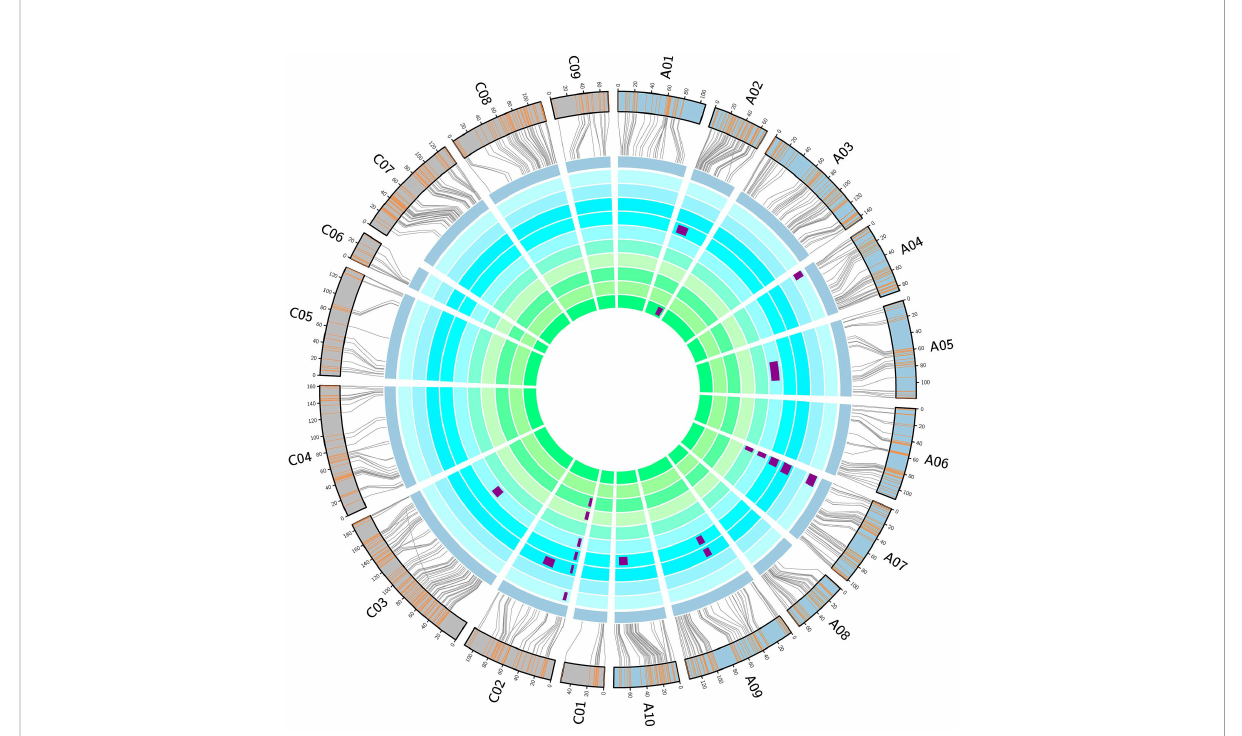
FIGURE 3 Genetic linkage map and locations of quantitative trait loci (QTL) for fl owering time (FT). From inside to outside, the ten cycles represent 15ZYFT1, 15ZYFT2, 16ZYFT1, 16ZYFT2, 15WHFT1, 15WHFT2, 16WHFT1, 16WHFT2, 16JZFT1, and 16JZFT2. The two outmost cycles show a comparison of the linkage and physical maps of Brassica napus